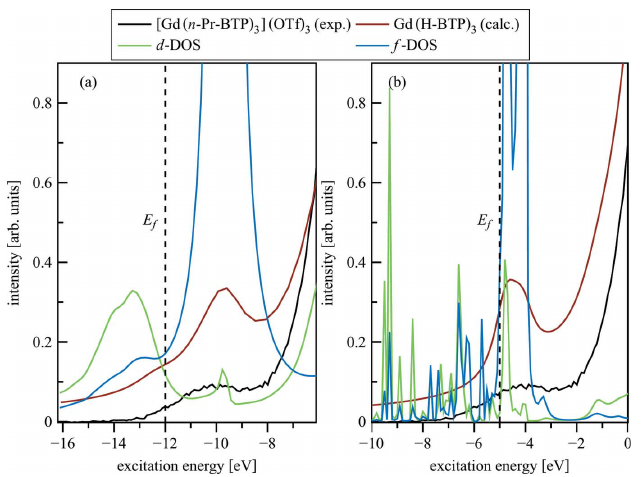
Figure 11 Pre-edge calculated with FEFF 9.5 ( a ) and FDMNES ( b ) for Gd(H- BTP) 3 , including Gd f -, d -DOS compared with experimental spectra of [Gd( n -Pr-BTP) 3 ](OTf) 3 .